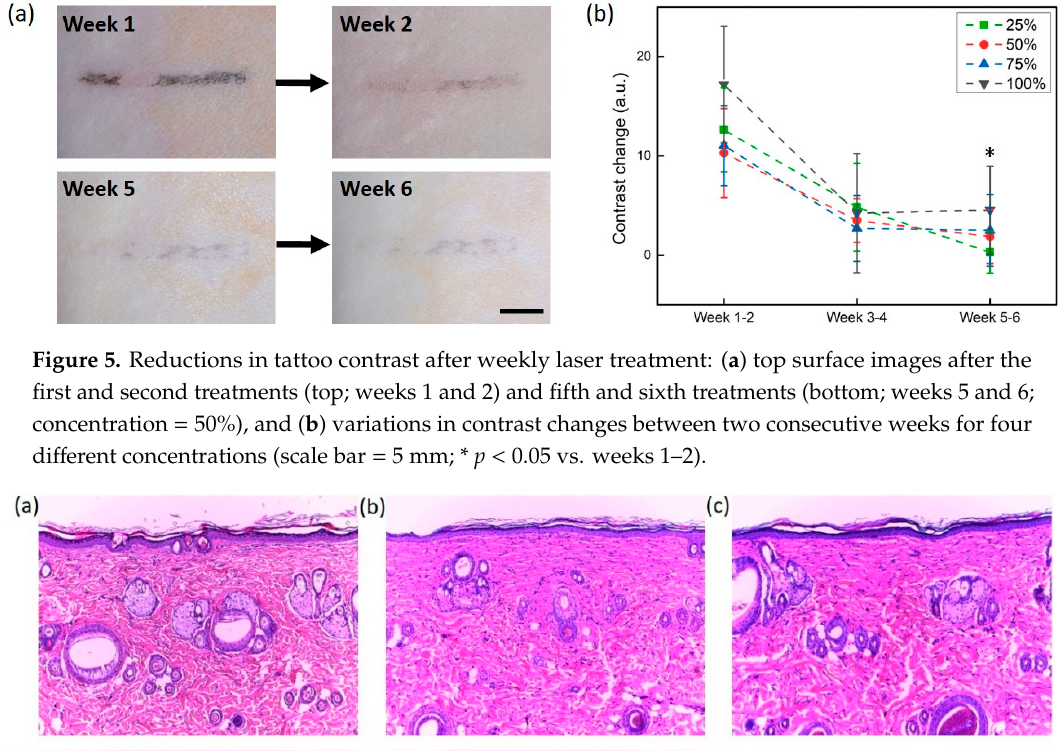
Figure 5. Reductions in tattoo contrast after weekly laser treatment: ( a ) top surface images after the first and second treatments (top; weeks 1 and 2) and fifth and sixth treatments (bottom; weeks 5 and 6; concentration = 50%), and ( b ) variations in contrast changes between two consecutive weeks for four different concentrations (scale bar = 5 mm; * p < 0.05 vs. weeks 1–2).